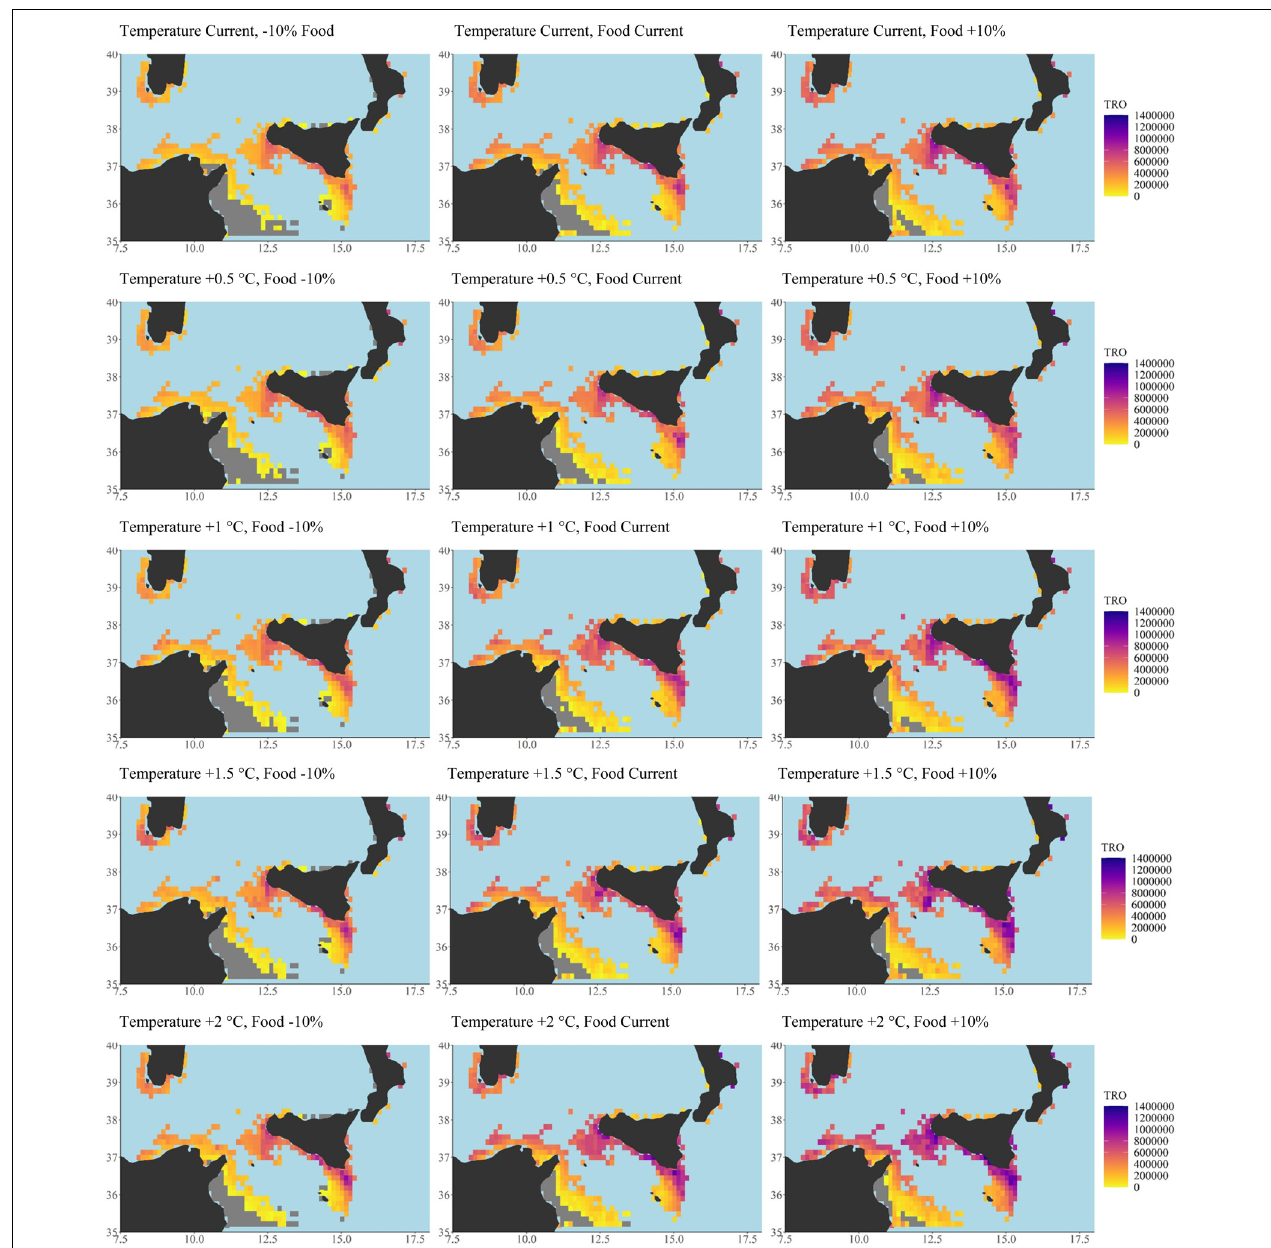
FIGURE 4 | Scenario-based quantitative maps of Total Reproductive Output (TRO, n. eggs/n. of reproductive events) described by a continuous scale ranging (from 0 to 1,400,000) under current conditions of both temperature and food (central panel) and under four increasing temperature scenarios (+0.5; +1.0; +1.5; +2.0 ◦ C from top line to bottom line, central) coupled with decreasing (oligotrophic, -10% net primary production, left side) and increasing trophic conditions (eutrophic +10% net primary production, right side). Minimum, maximum, mean and median values for each scenario have been also reported as well as the global G statistic values at Supplementary Table S3 . Total number of cells = 346, cell resolution of 12.5 × 12.5 km 2 . Maps were created using R software (ggplot2